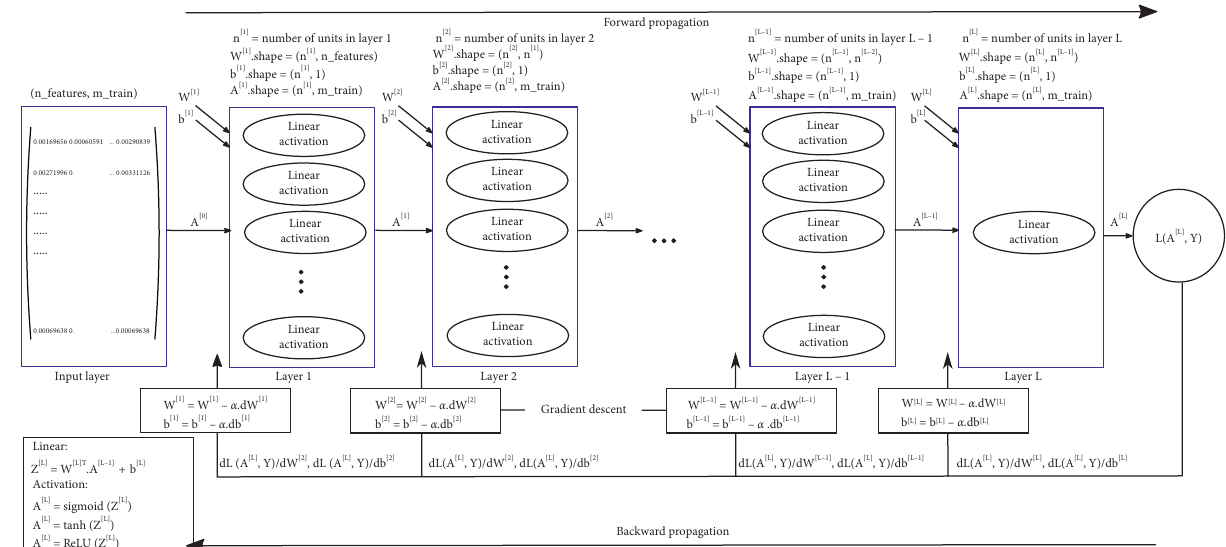
Figure 3: In Deep Neural Network, there are multiple hidden layers instead of a single layer of a Shallow Neural Network. In forward propagation, we compute linear and activation for all hidden layers and then compute the loss at the output layer. Then, through backpropagation, the derivative of loss with respect to weight and bias terms is calculated for all the layers in order to have optimized values of weight and bias terms. In the learning process, the forward propagation and backward propagation are performed for a number of iterations, until there is no further reduction in cost. W [ L ] and b [ L ] represent the weight and bias for layer L. A [ L − 1 ] is the input parameter to Layer L, and A [ L ] is the output produced from layer L. n [ L ] represents the number of units (also known as Neurons) in a given layer. α is the learning rate for the gradient descent algorithm. In Neural Networks and Deep Neural Networks,